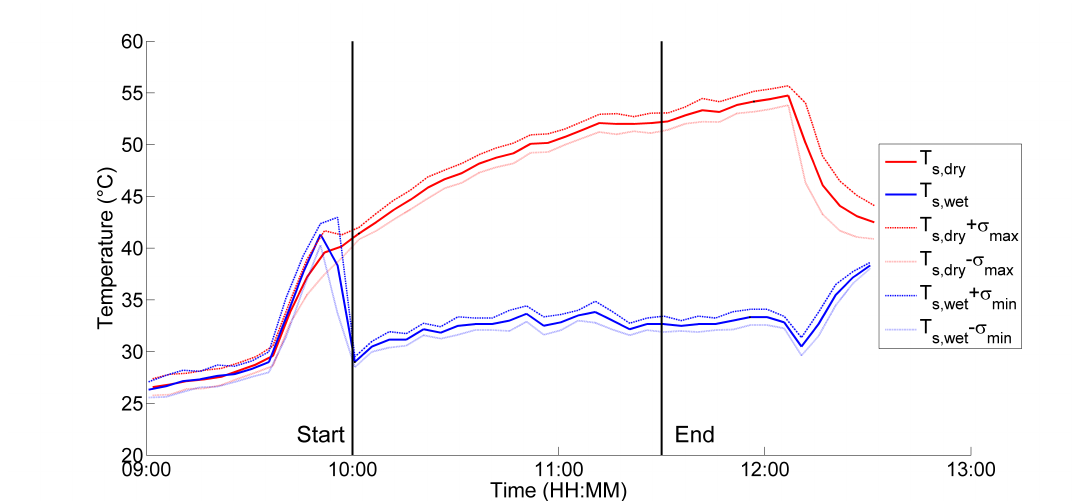
Figure 3. Mean and standard deviation of the in situ measurements performed on 8 May on the dry and wet soil plots of the R3 perimeter, Haouz plain. The two vertical lines stand for the beginning and the end of the